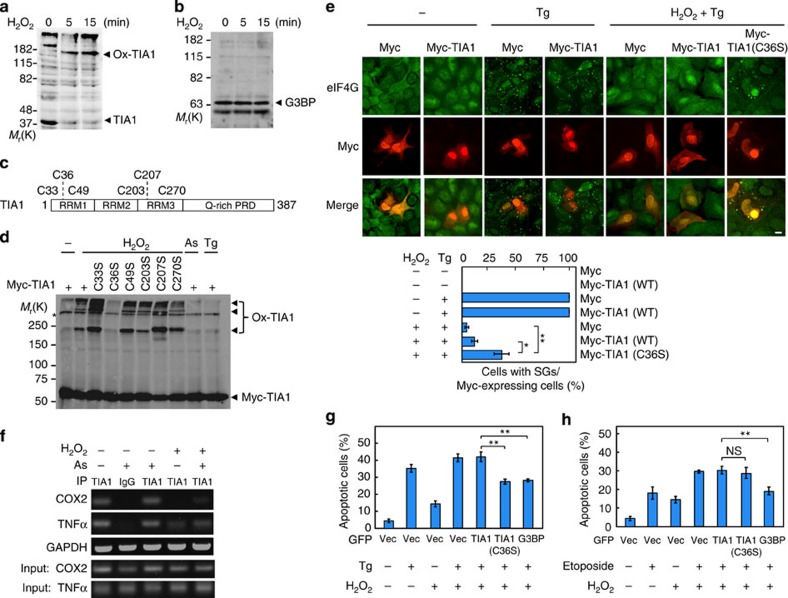
TIA1-Cys36 is oxidized by H2O2 and SG formation is suppressed.(a,b) COS cells were stimulated with 1 mM H2O2 for the indicated times and cell extracts were prepared under non-reducing conditions. (a) Endogenous TIA1 was probed by immunoblotting using anti-TIA1 antibody. Ox-TIA1, oxidized TIA1. (b) Endogenous G3BP was probed with anti-G3BP antibody. (c) Schematic structure of the TIA1 protein. PRD, prion-related domain. (d) Myc-tagged TIA1 point mutants were transiently transfected into U2OS cells. After 36 h, the cells were treated with 1 mM H2O2, 0.5 mM As or 1 μM Tg for 50 min. Cell extracts were prepared and Myc-TIA1 was probed with anti-Myc antibody under non-reducing conditions. (e) U2OS cells were transiently transfected as indicated. After 36 h, cells were treated with 1 μM Tg either alone or simultaneously with 200 μM H2O2 for 50 min. Myc-TIA1 and endogenous eIF4G were visualized by immunofluorescence. Scale bar, 10 μm. The percentage of Myc-expressing cells containing SGs was determined and is shown in the graph. Error bars indicate s.e.m. (n=4). *P<0.02, **P<0.01, Student's t-test. (f) U2OS cells were treated with 200 μM H2O2 and 0.5 mM as indicated, and were incubated for 50 min. A RIP assay was performed using anti-TIA1 antibody with rabbit IgG as a negative control. (g,h) Apoptosis induced by Tg was suppressed in cells expressing TIA1(C36S). U2OS cells were transfected as indicated (Vec, vector) and were cultured for 36 h. Cells were then treated with 10 μM Tg and/or 200 μM H2O2 (g) or with 50 μM Etoposide and/or 200 μM H2O2 (h) for another 20 h. To assess apoptosis, cells were stained with Annexin V-Cy3 and visualized by fluorescence microscopy. The number of red-positive apoptotic cells per GFP-positive green cells was determined. About 500 GFP-expressing cells were scored to calculate the percentage of apoptotic cells. Error bars indicate s.e.m. (n=4). **P<0.01. NS, not significant, Student's t-test.